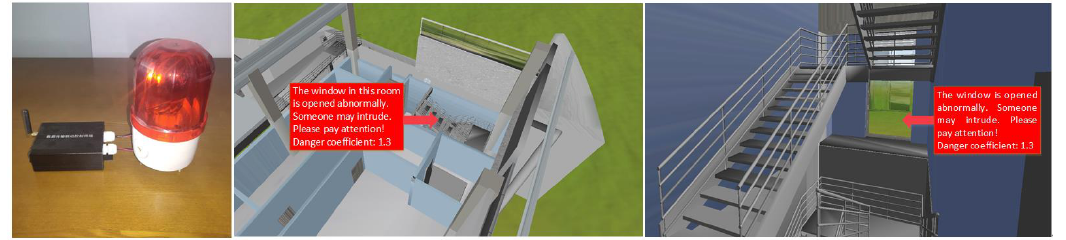
Figure 16. Prediction results for the danger coefficient.